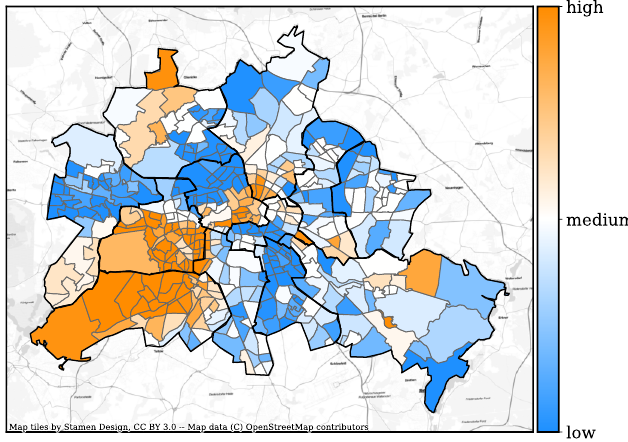
Figure 3. Household income distribution in the Berlin LORs.